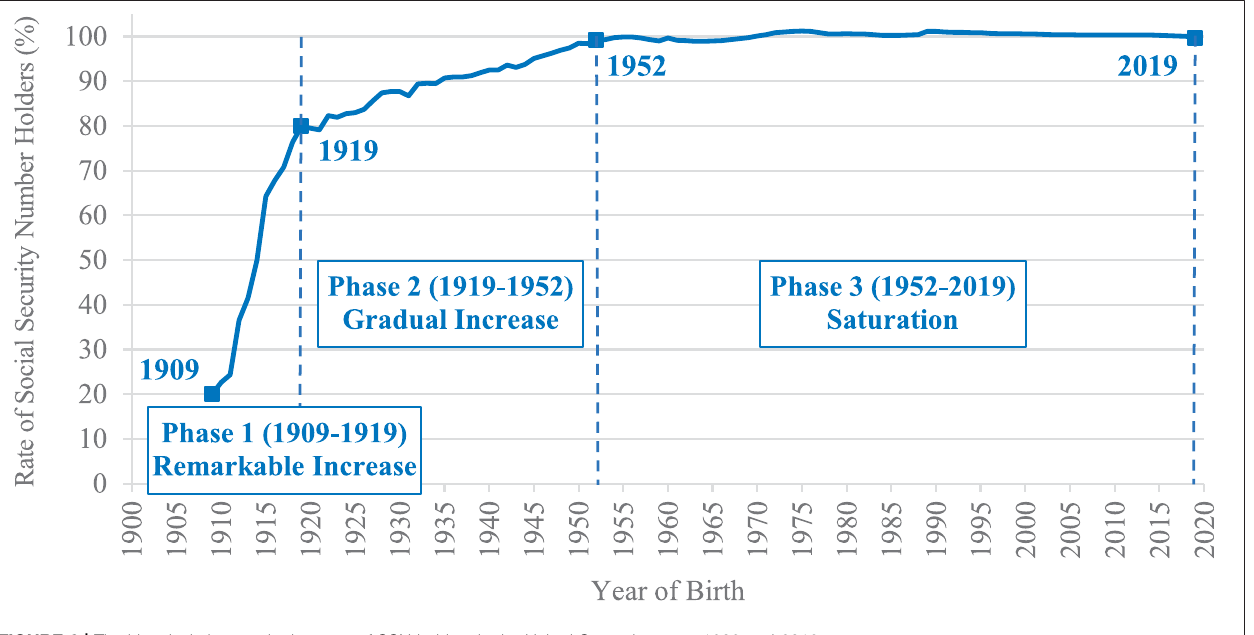
FIGURE 2 | The historical changes in the rates of SSN holders in the United States between 1909 and